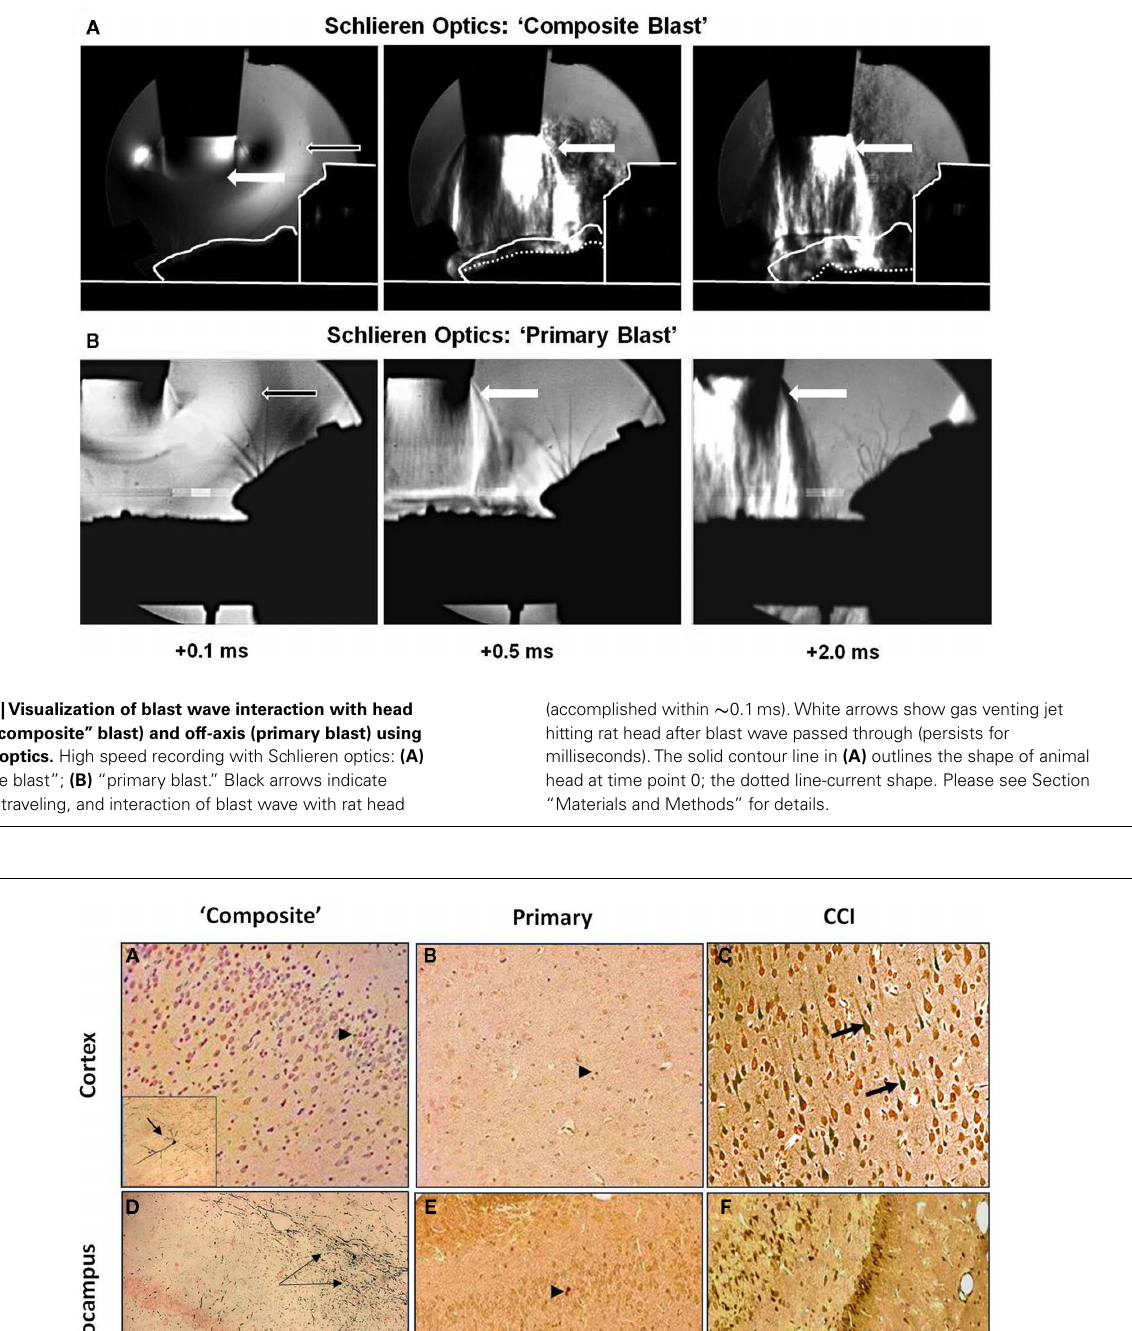
FIGURE 3 | Silver Staining of coronal brain sections following primary or “composite” blast exposure. Corresponding tissue staining 7days after “composite blast,” primary blast, and CCI is shown in (A–C) for cortex, and in (D–F) for hippocampus. Arrowheads indicate occasional